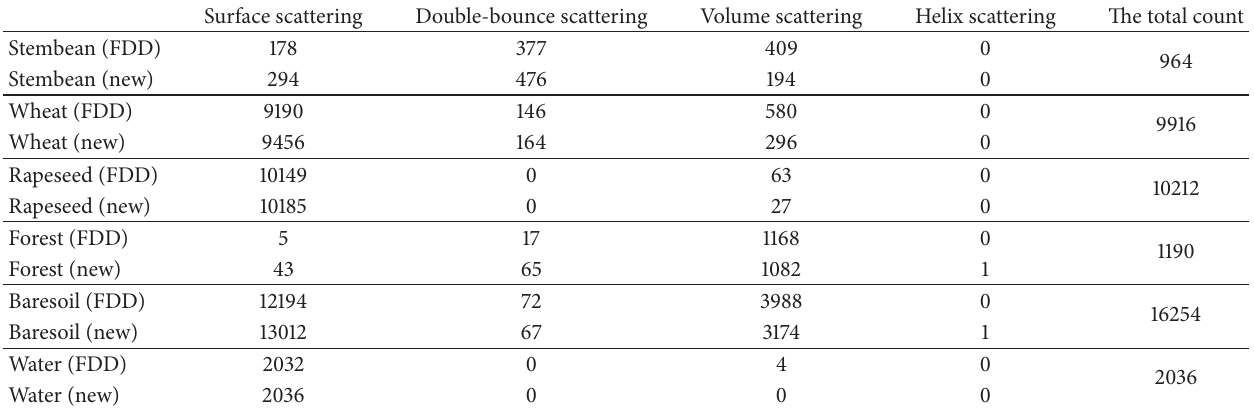
Table 1: Classification accuracy of six